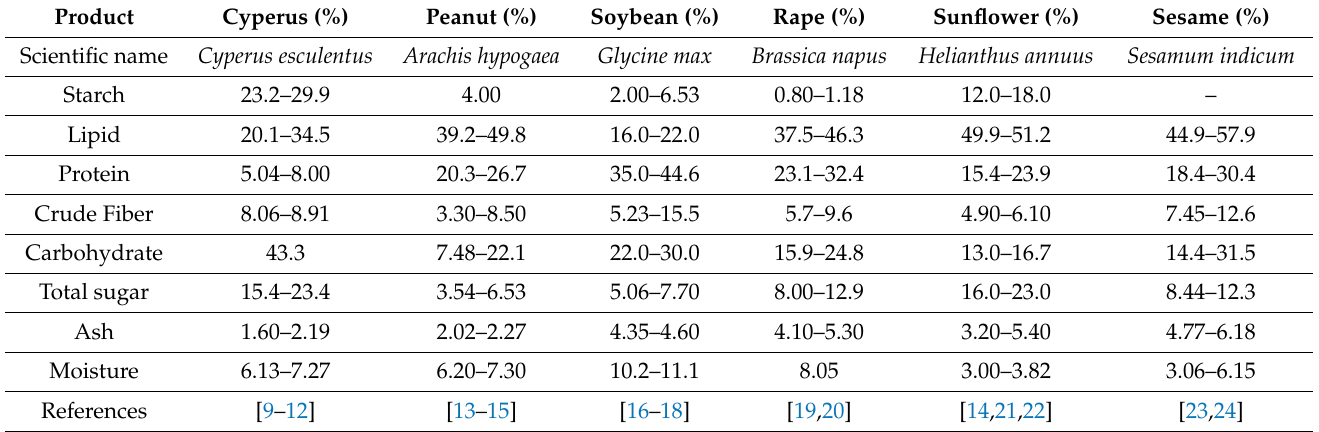
Table 1. Main composition and content of cultivated Cyperus ( Cyperus esculentus L.) tubers compared to these of key oil crops.